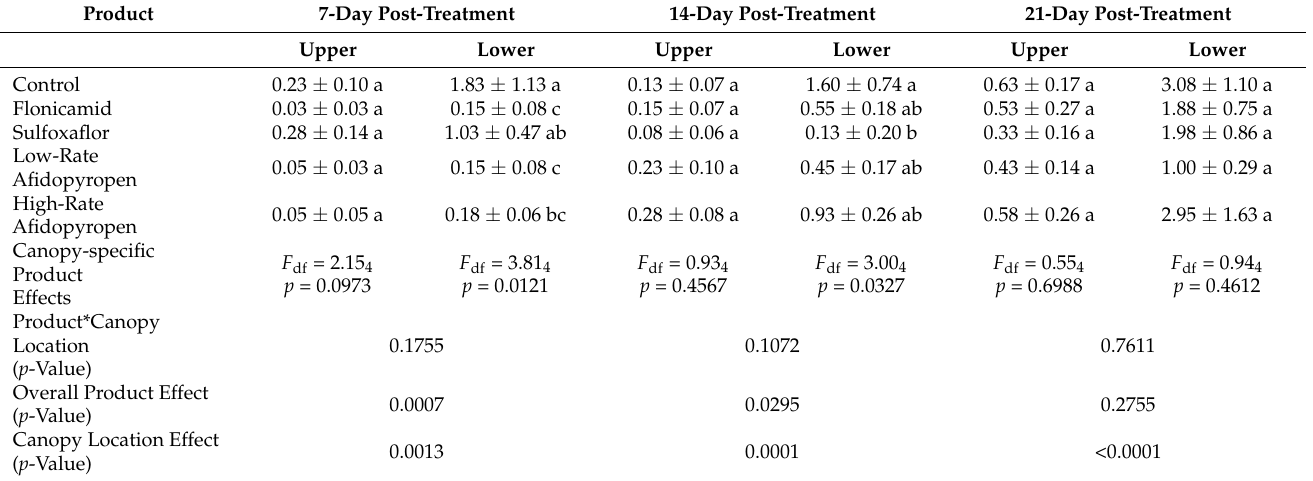
Table 4. Mean ± SEM of total pecan aphids per leaf across treatments and sample days in 2020. Differing letters in columns indicate a significant difference between treatments ( p < 0.05 Tukey’s HSD). Canopy-specific product effects and p -values for product*canopy interaction, overall product effect, and canopy location across sampling days are also shown. Application rates for each aphicide are based on the standard label